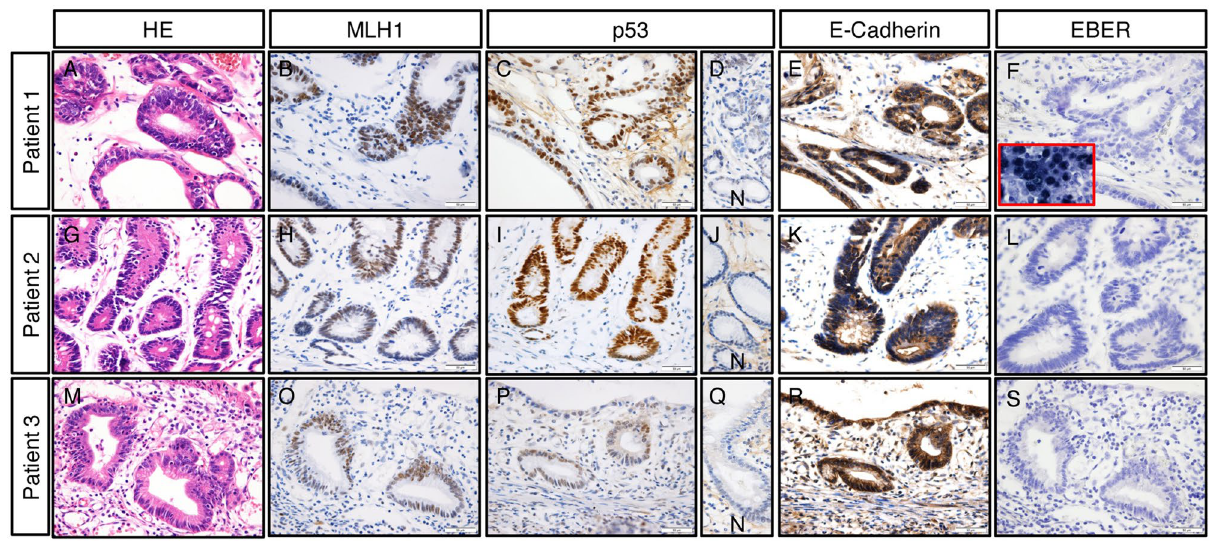
Figure 4. TCGA classification by immunohistochemistry and EBER for the three NHPH positive gastric cancer. ( A , G , M ) Hematoxylin and eosin staining for gastric cancer in Patients 1, 2, and 3, respectively. ( B , H , O ) MLH1 staining was positive for all three gastric cancers and no microsatellite instability was indicated. ( C , I , P ) p53 staining was positive and p53 was aberrantly expressed in all three gastric cancers. ( D , J , Q ) p53 staining in the non-cancerous part of gastric mucosa in each patient. P53 was not aberrantly expressed in normal regions. ( E , K , R ) E-cadherin was positive in all three cancers. ( F , L , S ) EBER in situ hybridization. Epstain-Barr virus was negative in all three stomachs. Inset in ( F ) shows positive control. ( N ) shows the surrounding non-cancerous parts. Taken together, all three gastric cancers were classified into the Chromosomal Instability (CIN)